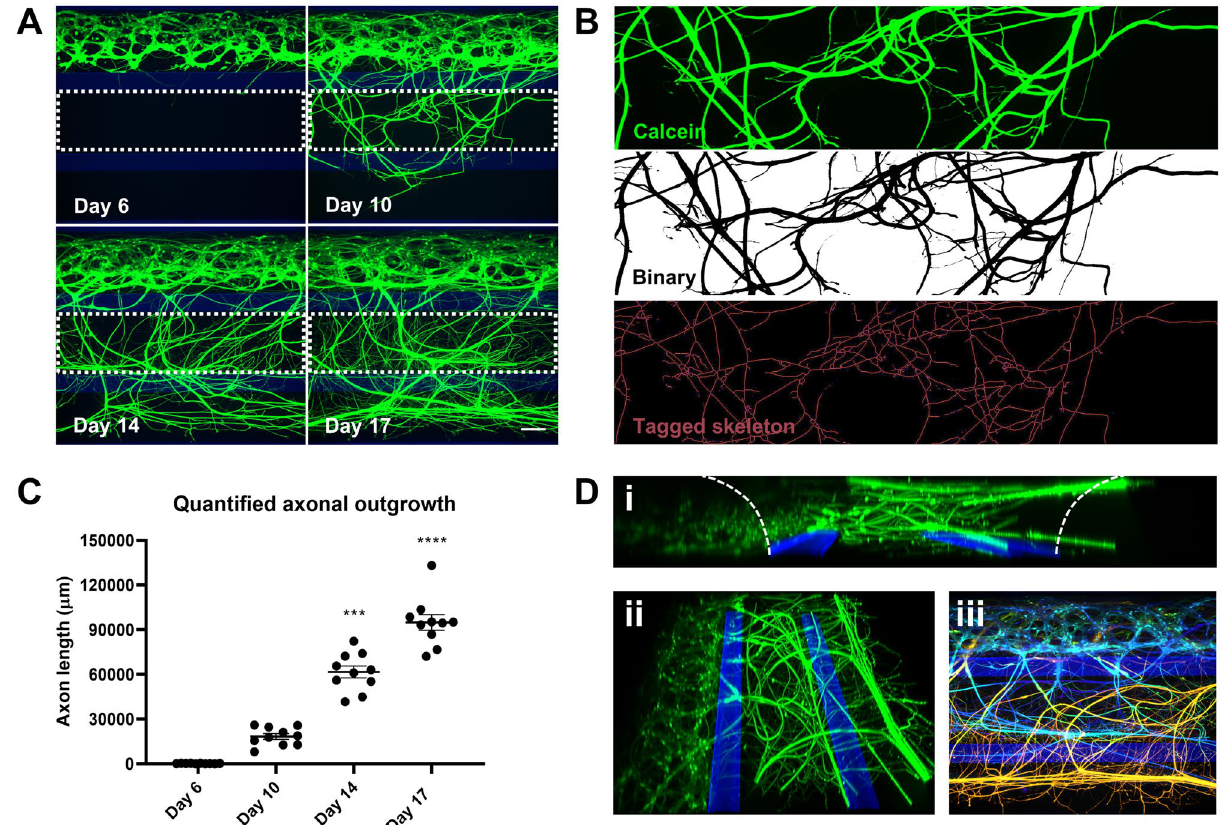
Figure 3. Characterization of 3D axon outgrowth. ( A ) Motor neuron axon outgrowth over time, visualized using calcein-AM dye. Dashed lines indicate region of interest (ROI) used for axon outgrowth quantification. Maximum projection images, the scale bar is 140 µm. ( B ) Quantification of axon outgrowth in the middle lane at day 17. Green-fluorescent signal of calcein-labeled axons was converted into a binary image, and subsequently converted into a skeletonized image that allows quantification of neurite length. ( C ) Quantification of motor neuron axon outgrowth over time using the procedure depicted in b. Graph shows mean neurite length ± SEM, n = 10, N = 2. *** (P < 0.001), **** (P < 0.0001); Kruskall–Wallis test. The graphic representation was created using GraphPad Prism, version 8.3.1 (https ://www.graph pad.com/scien tific -softw are/prism /). ( D ) 3D reconstruction of neuronal network and axonal outgrowth rendered from a confocal Z-stack, visualized using a calcein-AM dye at day 17. A side view is shown in panel i. Panel ii shows a top view. Panels i and ii were created using Imaris Viewer (https ://imari s.oxins t.com/imari s-viewe r). Panel iii depicts the Z-axis of the culture, in which structures at different depths within the chip are depicted using a color gradient to visualize the 3D nature of the culture. Deeper structures are depicted in blue, more superficial structures are depicted in green, followed by yellow and orange. Panel iii was created in ImageJ 76 determined to be 0.5039 nM. To further characterize these experiments, LDH release was measured as an indi- cator of cytotoxicity. Vincristine substantially affected axon outgrowth, while only at the highest concentration tested vincristine may lead to increased LDH activity (P = 0.065; Supplementary Fig. S5). These results indicated that our treatment can specifically target axon outgrowth and stability. Glutamate toxicity is a hallmark of diseases such as ALS (Taylor et al., 2016). To examine whether we could model this pathological situation in the OrganoPlate culture, we exposed cultures to 5 mM glutamate for 7 days (day 10–17), in line with a previous study 32 . Excess glutamate significantly reduced axon outgrowth as compared to control treatment (P = 0.041; Fig. 5A,B). Exposure to sodium arsenite is another commonly used treatment for studying neuronal vulnerability in ALS and other diseases, as patient cells may respond differently to cellular stress 37–39 . Short-term exposure to sodium arsenite (3 h) did not significantly reduce axon outgrowth (Fig. 5A,B), but did induce formation of SGs, as did treatment with excess glutamate (Fig. 5C). SGs are accumulations of proteins and RNAs, mostly consisting of stalled translation initiation complexes, that form in a reversible manner upon cellular stress. Treatment with glutamate or sodium arsenite induced SG formation as shown by G3BP1 immunostainings. G3BP1 is a major component of SGs and shows a diffuse expression pattern in control conditions. Following both treatments, more granular patterns were found that are indicative of SG formation (Fig. 5C). We confirmed that the SGs are formed in neurons rather than non-neuronal cells, as results from immunostaining (data not shown) and qPCR analysis only showed sporadic presence of glial cells in our cul- tures. The low mRNA levels of s100β are presented in Supplementary Fig. S1. As expected, FUS remained mostly nuclear in all conditions (Fig. 5C), indicating that the incorporation of FUS in SGs requires ALS mutations in